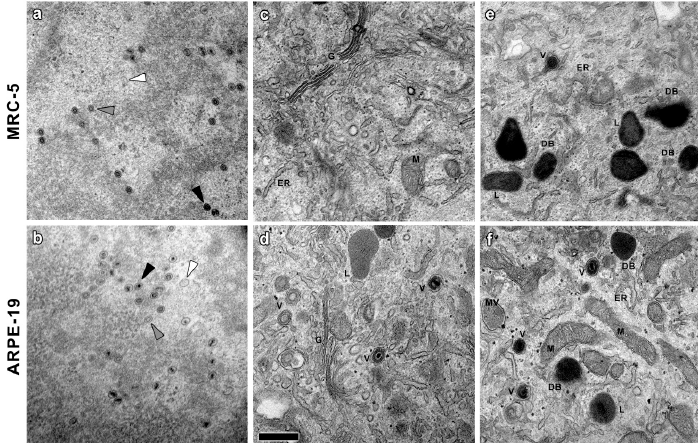
Figure 3. High magnification details of CMV-infected MRC-5 and ARPE-19 cells. ( a , b ) CMV nucleocapsids emerging from electron dense material (presumably nuclear inclusions) in the nucleoplasm. Empty A-capsids, scaffold-loaded B-capsids and DNA-loaded C-capsids are indicated with white, grey and black arrowheads, respectively. ( c , d ) Cytoplasmic areas with accumulation and proliferation of putative Golgi elements and capsids with tegument. ( e , f ) Electron-dense material similar to previously described DB, always located in cytoplasm areas rich in viral capsids and Golgi-like elements. Cellular organelles and structures are indicated: V––extranuclear viral capsids, DB––dense bodies, L––liposomes, MV––multivesicular